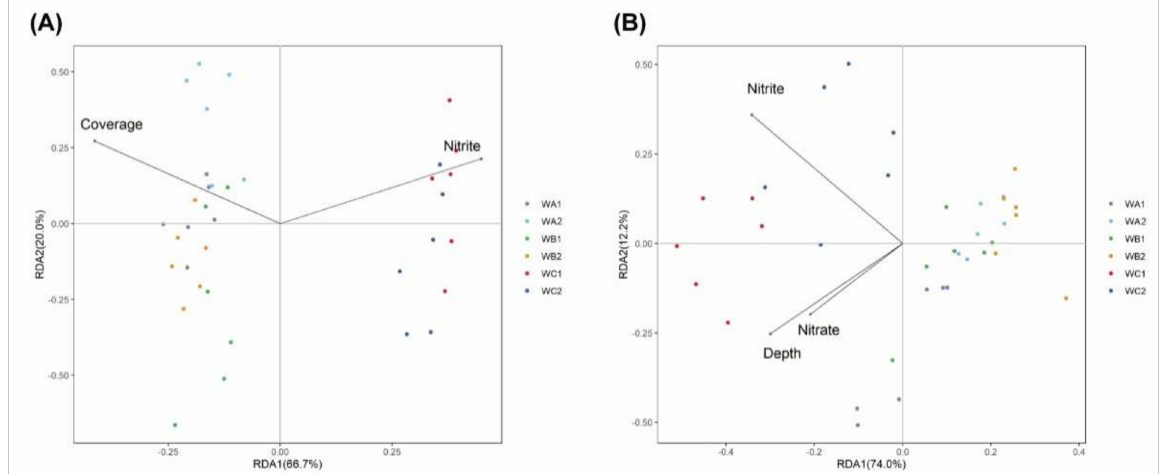
Figure 3. Ordination diagrams from redundancy analysis (RDA) of 16S rRNA ( A ) and cbbL ( B ) communities and environmental parameters ( n = 6). Arrows indicate the direction and mag- nitude of environmental variables associated with 16S rRNA and cbbL community structures. Each sample is represented by a colored